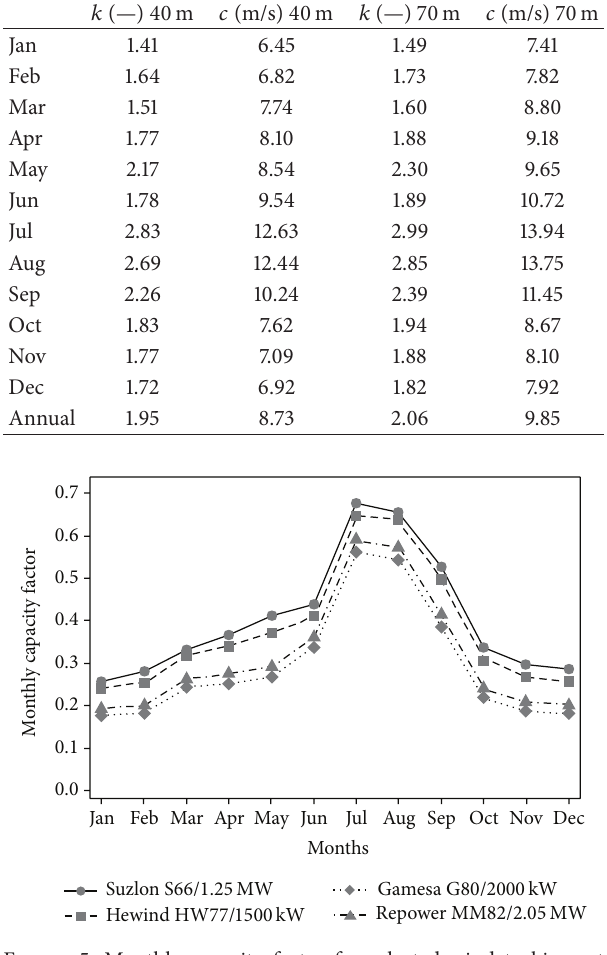
Figure 5: Monthly capacity factor for selected wind turbines at Jarandagh site.